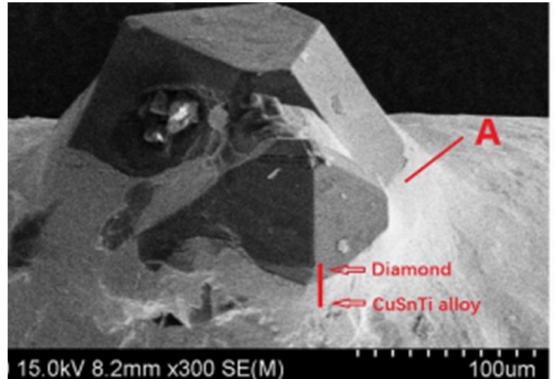
Figure 35. Interface microstructure between Cu-Sn-Ti filler alloy and diamond grits [79].